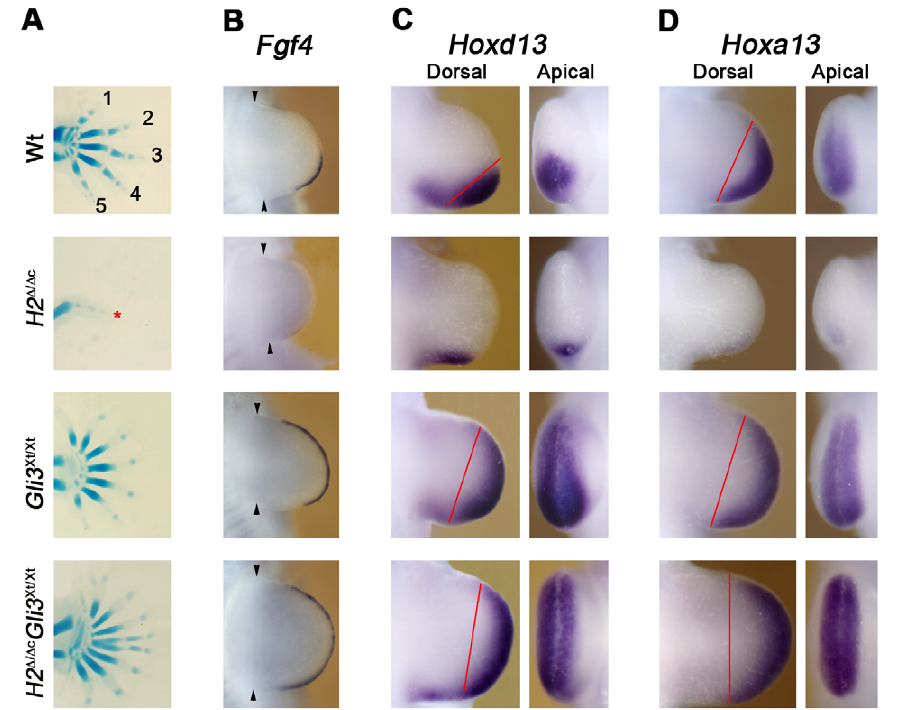
Figure 7. Apolar expression of Fgf4 , Hoxd13 , and Hoxa13 in the autopod primordia of H2 D / D c Gli3 Xt/Xt forelimb buds. (A) Skeletal preparations of the autopod (E14.5) of H2 D / D c Gli3 Xt/Xt , H2 D / D c , and Gli3 Xt/Xt single mutant and wild-type forelimbs. Digit identities are indicated by numbers 1 (thumb, anterior) to 5 (little finger, posterior). Black asterisks indicate digits with undetermined identities; red asterisk indicates the rudimentary digit formed in H2 D / D c forelimbs. (B) Fgf4 expression in the AER of wild-type and mutant limb buds at E10.5 (36 somites). Fgf4 is expressed at very low levels in the posterior of in H2 D / D c limb buds, but expands throughout the AER of H2 D / D c Gli3 Xt/Xt forelimb buds. Arrowheads indicate the anterior and posterior margins of limb buds. (C) Hoxd13 expression at E10.75 (40 somites). The late Hoxd13 expression domain in H2 D / D c Gli3 Xt/Xt limb buds appears symmetrical in contrast to e.g. Gli3 deficient limb buds (expression borders are indicated by red lines). This is best seen by comparing apical views. (D) Hoxa13 expression at E10.75 (41 somites). The Hoxa13 expression domain appears also symmetrical in H2 D / D c Gli3 Xt/Xt limb buds, while some asymmetry is retained in Gli3 deficient limb buds (red lines in dorsal views; best seen by comparing the apical views).